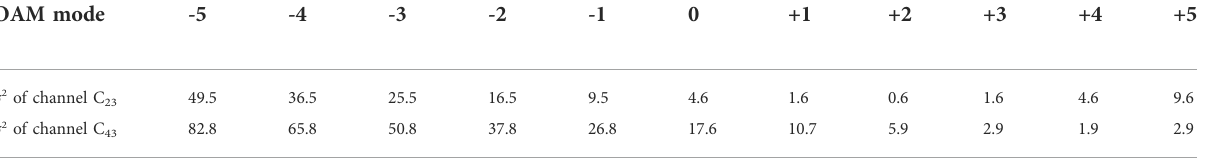
TABLE 1 The calculated variances σ 2 for different OAM